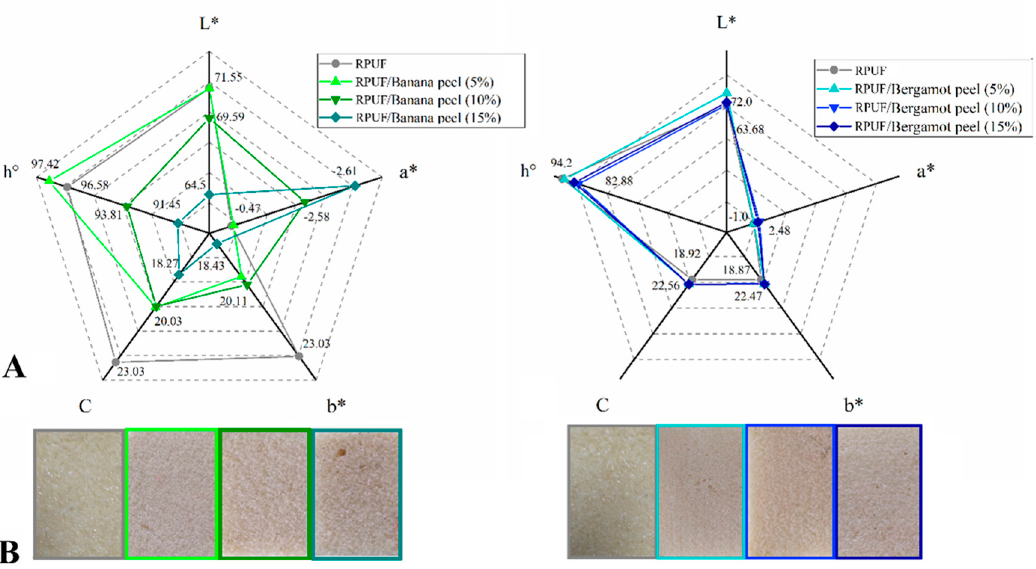
Figure 9. Colorimetric properties ( A ) and photographs ( B ) of the studied RPUF with Banana peels ( A ) and Bergamot peels ( B ). RPUF is the neat rigid polyurethane foam and filler type, and filler content is the numbers after the bars and between parentheses, respectively. Where: L* is brightness; a* is green-red coordinate; b* is blue-yellow coordinate; C is chroma; h° is hue angle.